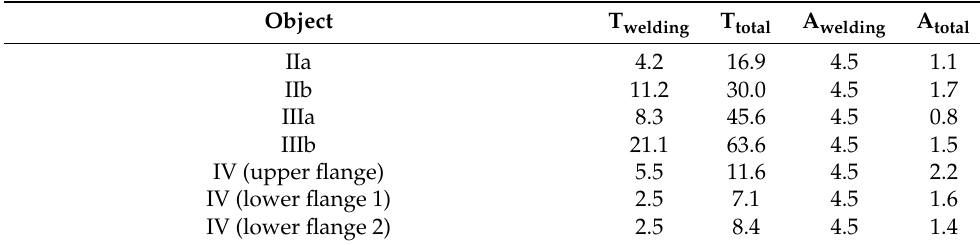
Table 3. Production times T (min) and build-up rates A (cm³/min) of each